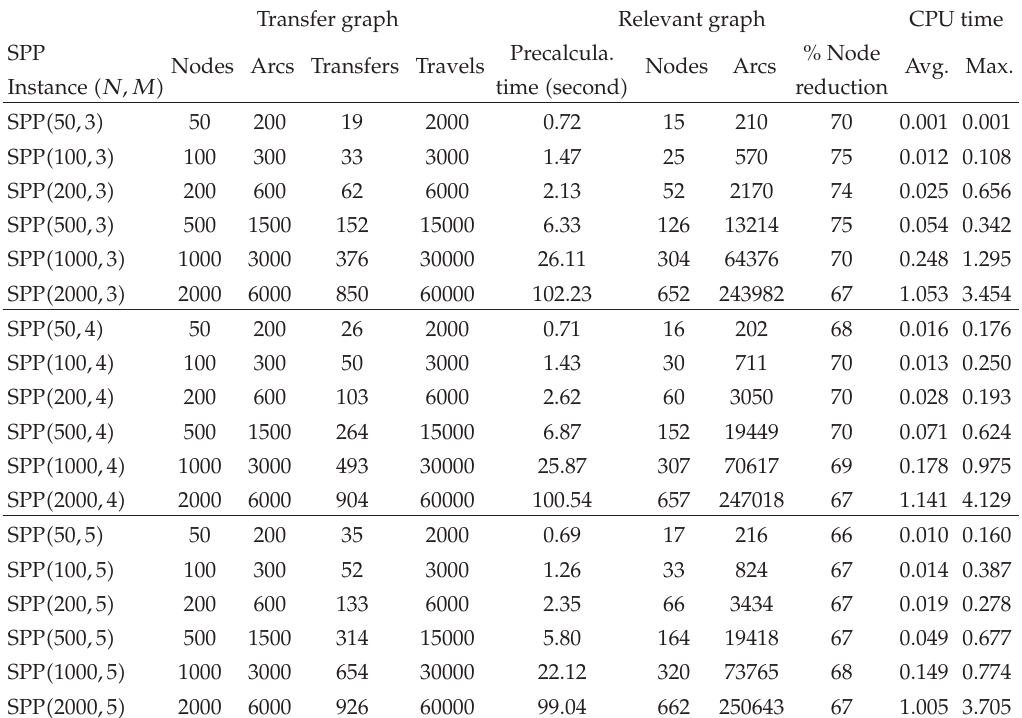
Table 3: Performance and graph reduction for di ff erent instances of the SPP with variable transport modes, number of nodes and arcs. Transfer graph Relevant graph CPU time